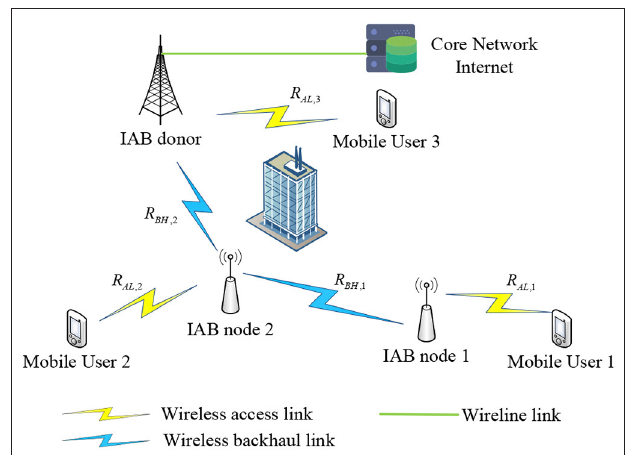
FIGURE 2 | Integrated access and backhaul system